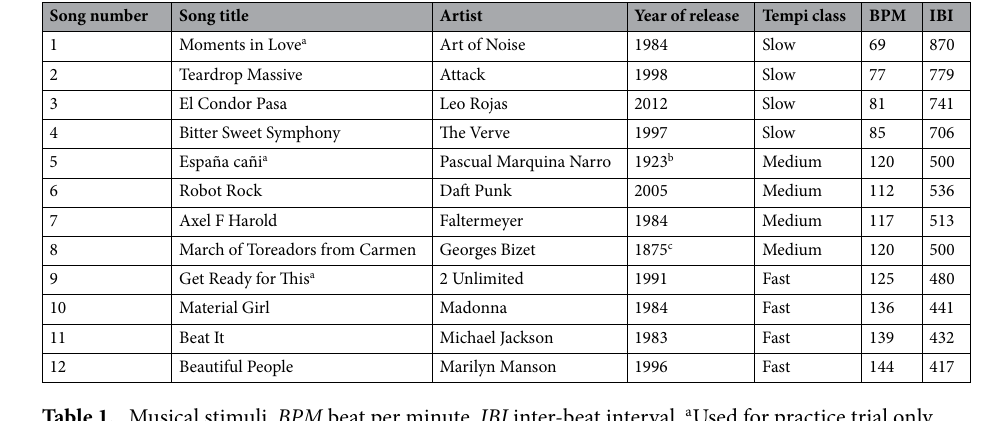
Table 1. Musical stimuli. BPM beat per minute, IBI inter-beat interval. a Used for practice trial only. b Recording in 2010. c Recording in 2011.